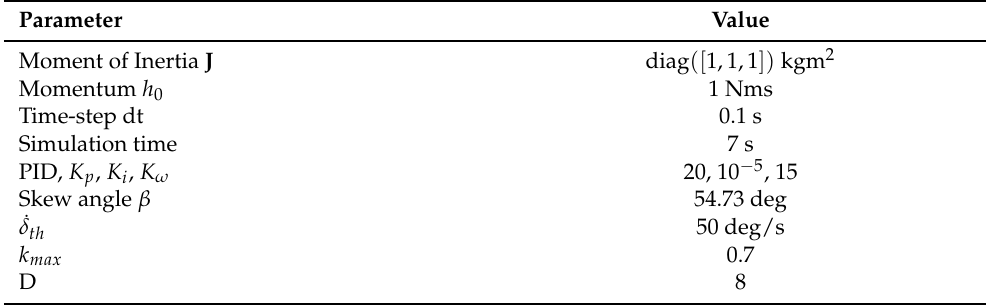
Table 2. Simulation